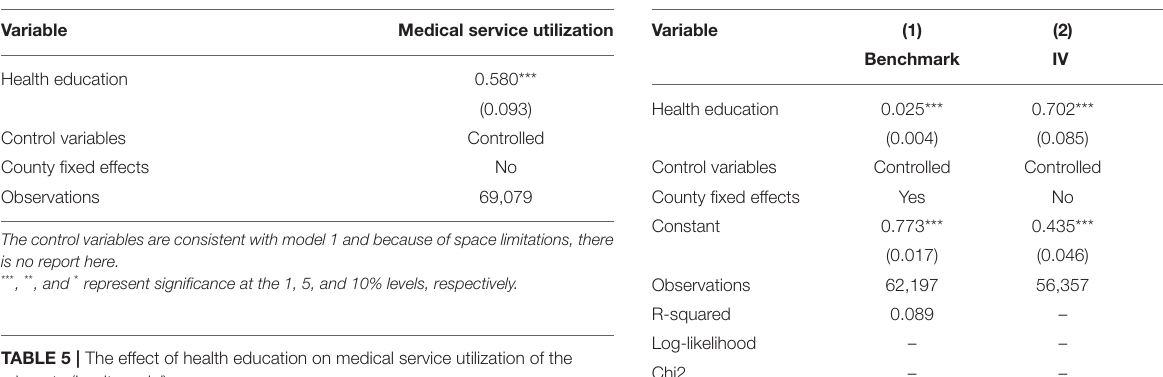
TABLE 6 | The effect of health education on medical service utilization of the migrants (Alternate dependent